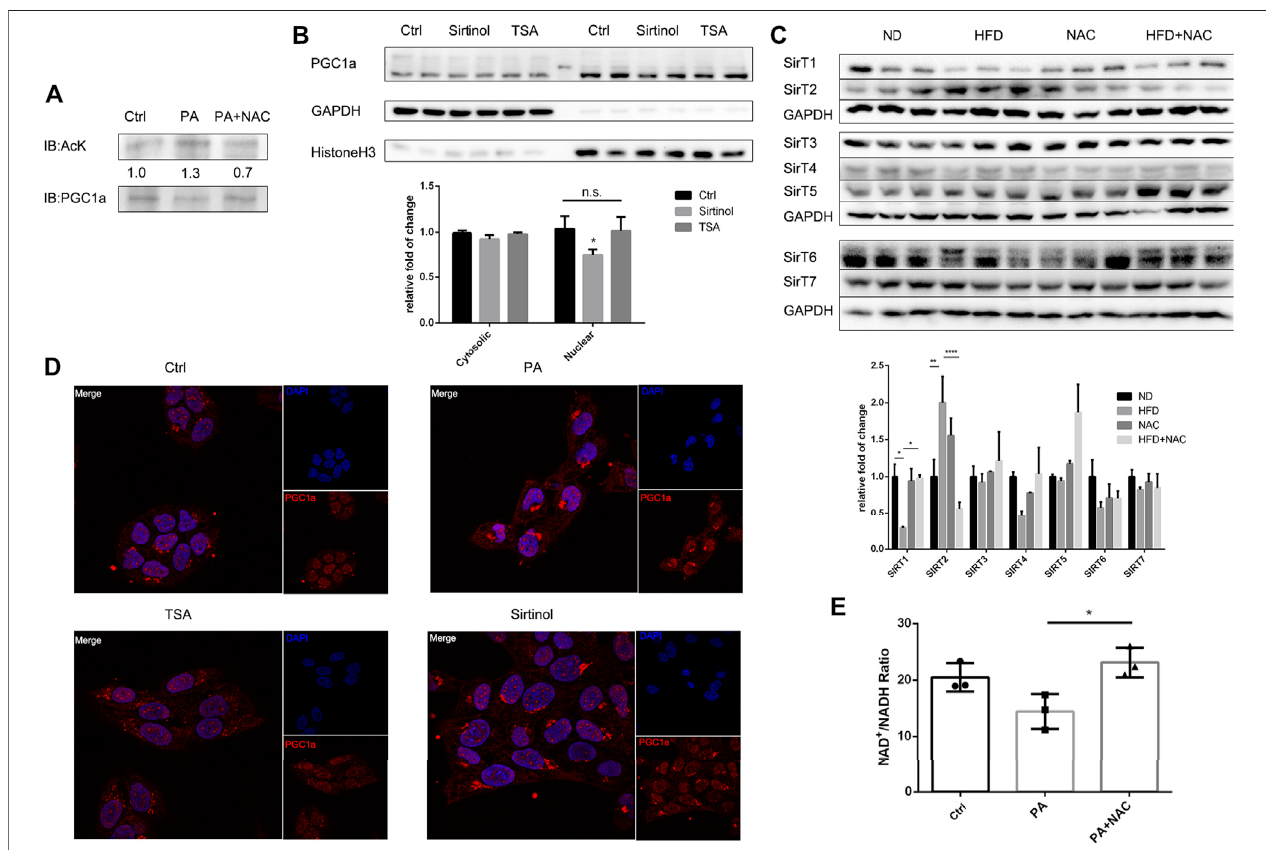
FIGURE 5 | NAC activated Sirt1 to deacetylate PGC1a and maintained its mitochondria biogenesis activity. (A) Immunoprecipitation of PGC1a in LO2 cells underwentdifferenttreatmentandWesternblotanalysisofacetylatedlysineresidueinimmunoprecipitatedPGC1a; (B) separationofnuclearandcytosolicproteinunder Sirtinol or TSA treatment and protein level of PGC1a measured by Western blot; (C) Western blot analysis of protein level of Sirtuin family in mice hepatic tissue; (D) immuno fl uorescence analysis of subcellular localization of PGC1a after TSA or Sirtinol treatment; scale bar was 10 μ m; (E) NAD + /NADH ratio of LO2 cell after PA stimulation or NAC treatment. The experiment was conducted triple (* p < 0.05; all the data signi fi cance was analyzed by